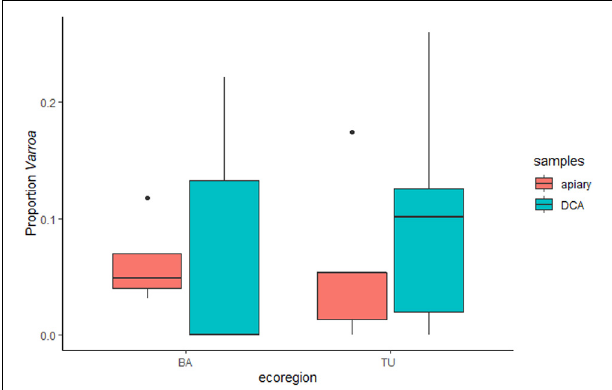
FIGURE 2 | Box-and-whisker plot of the arcsine-transformed proportion of Varroa in samples taken from apiaries and from Drone Congregation Areas at the two ecoregions, Buenos Aires (BA) and Tucumán (TU). Each box shows the lower and upper quartiles, the black line within the box is the median, and the error bars are the minimum and maximum values, respectively.